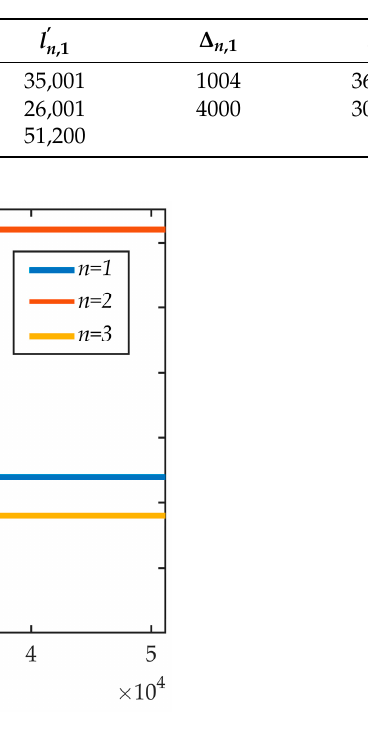
Figure 15. Schematic diagram of multiple FH signals with frequency-switching time.